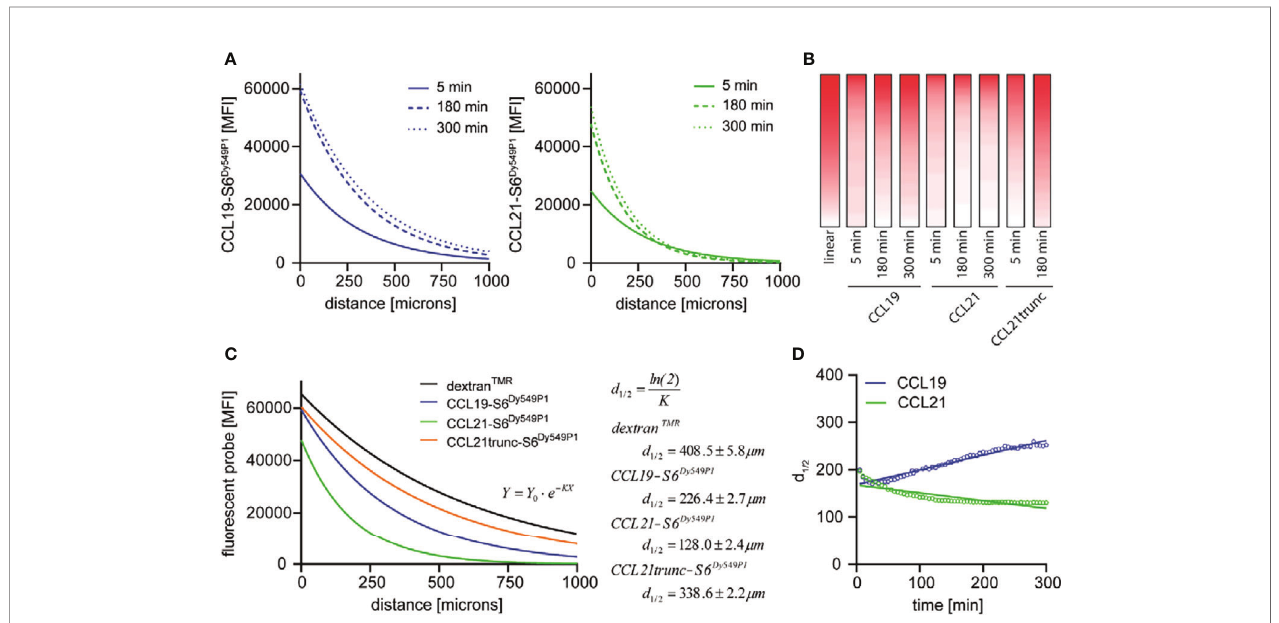
FIGURE 2 | CCL19, CCL21 and CCL21trunc establish stable gradients of distinct shapes. (A) Mean fl uorescence intensity (MFI) of CCL19-S6 Dy549P1 and CCL21- S6 Dy649P1 in relation to the distance to the reservoir measured after 5 min, 180 min and 300 min of incubation. (B) MFI values of CCL19-S6 Dy549P1 , CCL21- S6 Dy649P1 [taken from (A) ] and CCL21trunc-S6 Dy549P1 were translated in a pseudocolor representation, and supplemented with an arti fi cial linear gradient for comparison. (C) Applying a one-phase exponential decay function reveals different 50 % initial fl uorescence values (d 1/2 ) for dextran TMR , CCL19-S6 Dy549P1 , CCL21- S6 Dy549P1 and CCL21trunc-S6 Dy549P1 after 180 min. (D) Spatial distribution of d 1/2 as the ‘ mean chemokine diffusion ’ over time increases for CCL19-S6 Dy549P1 , but not for CCL21-S6 Dy549P1